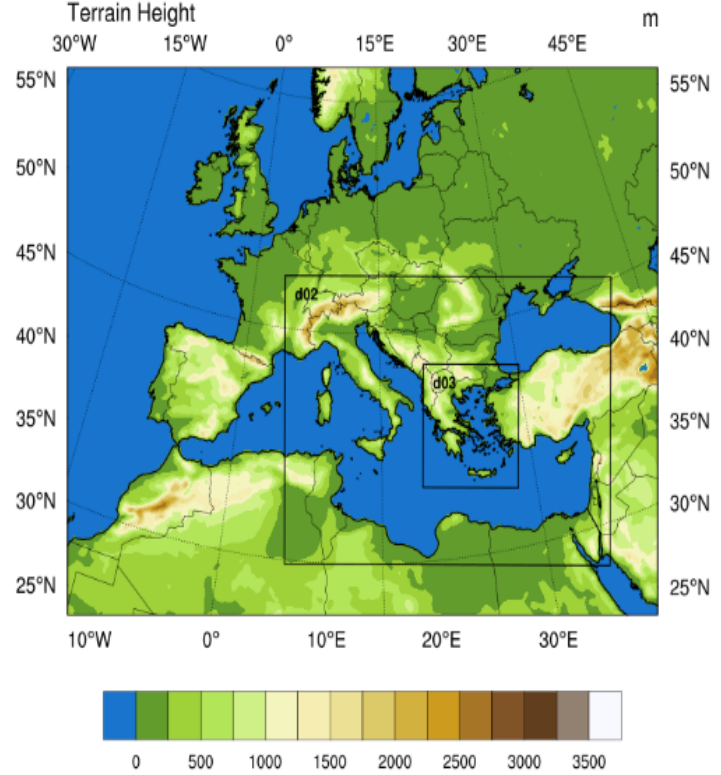
Figure 1. Integration domains of the modeling system. The outer domain has a spatial resolution of 18 km, down to d02 of 6 km and enclosing Greece with a spatial resolution domain (d03) of 2 km.